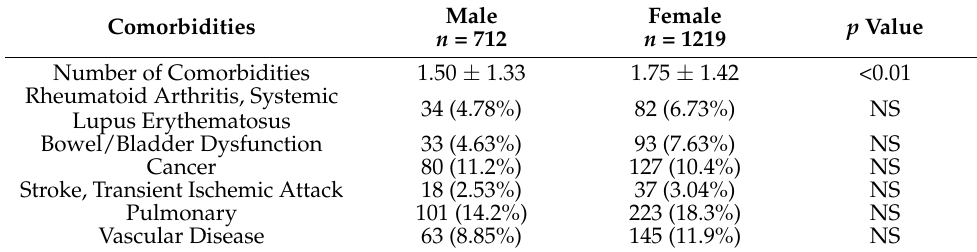
Table 3. Patient comorbidities separated by